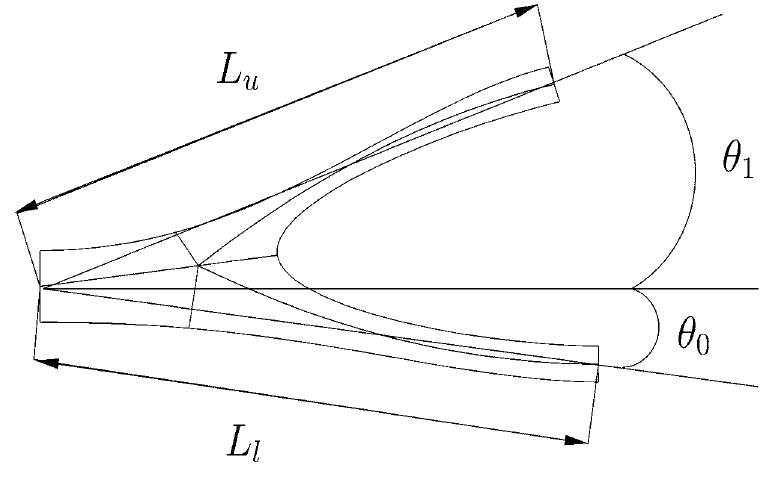
Figure 3. The parameters used to define the